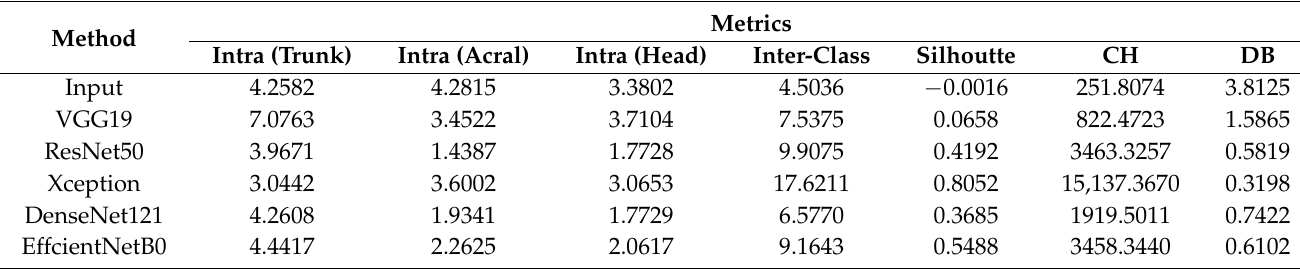
Figure 5. Visualization of full dataset feature distributions extracted with VGG19, ResNet50, Xception, DenseNet121, and EfficientNetB0. These graphs visually illustrate the separability of three anatomic sites. Table 3. Statistical analysis on the separability of three anatomic sites (trunk, acral, and face/head) of the HAM10000 dataset using UMAP visualization on deep learning